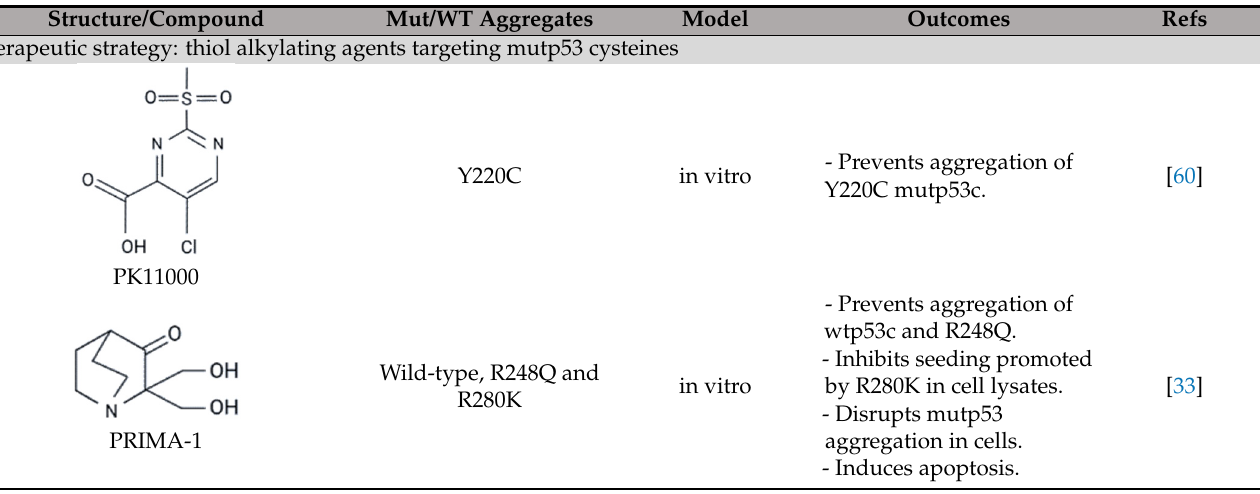
Table 1. Published strategies and compounds tested for mutp53 aggregation inhibition.